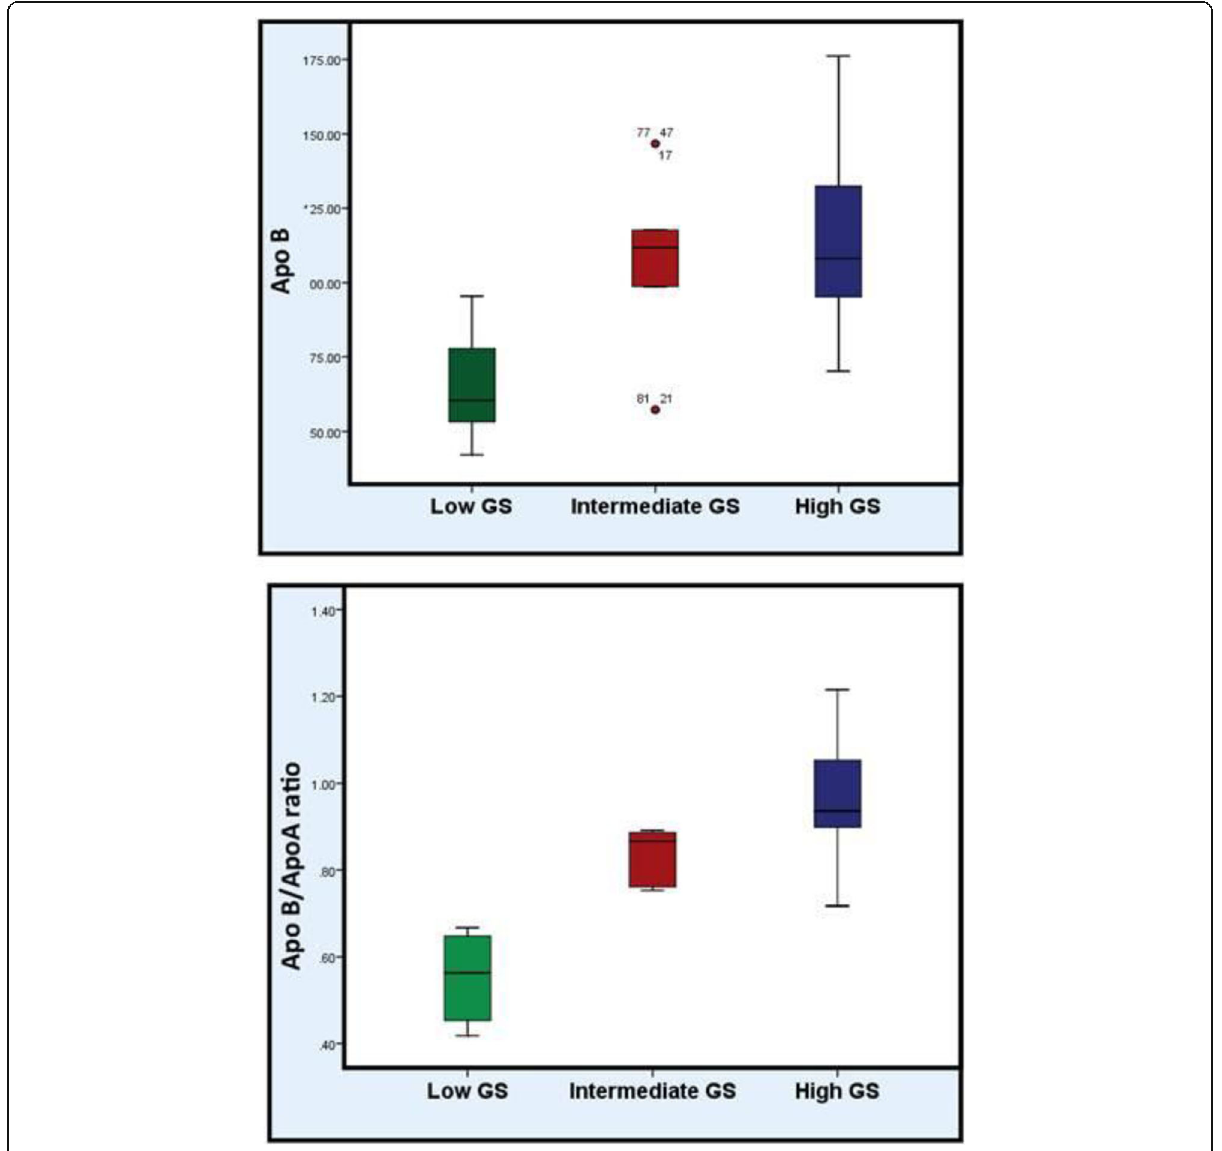
Fig. 1 Comparison between the studied patients as regard Apo B and Apo B/ApoA